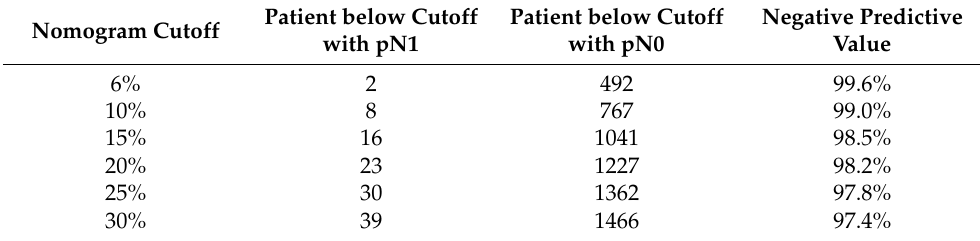
Table 3. Systematic analyses of the nomogram-derived probability cutoffs for prostate cancer with lymph node